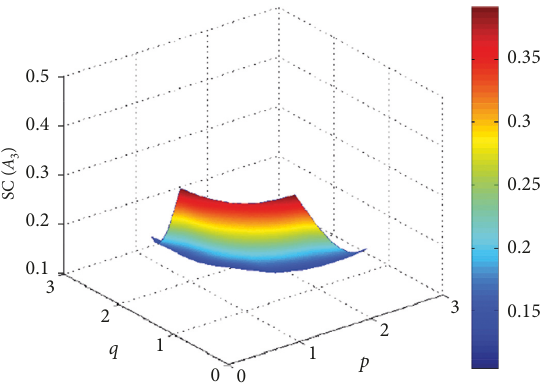
Figure 13: SC ( F ) of A based on the A-HF2TLWBM operator and the A-HF2TLWGBM operator. 3 3